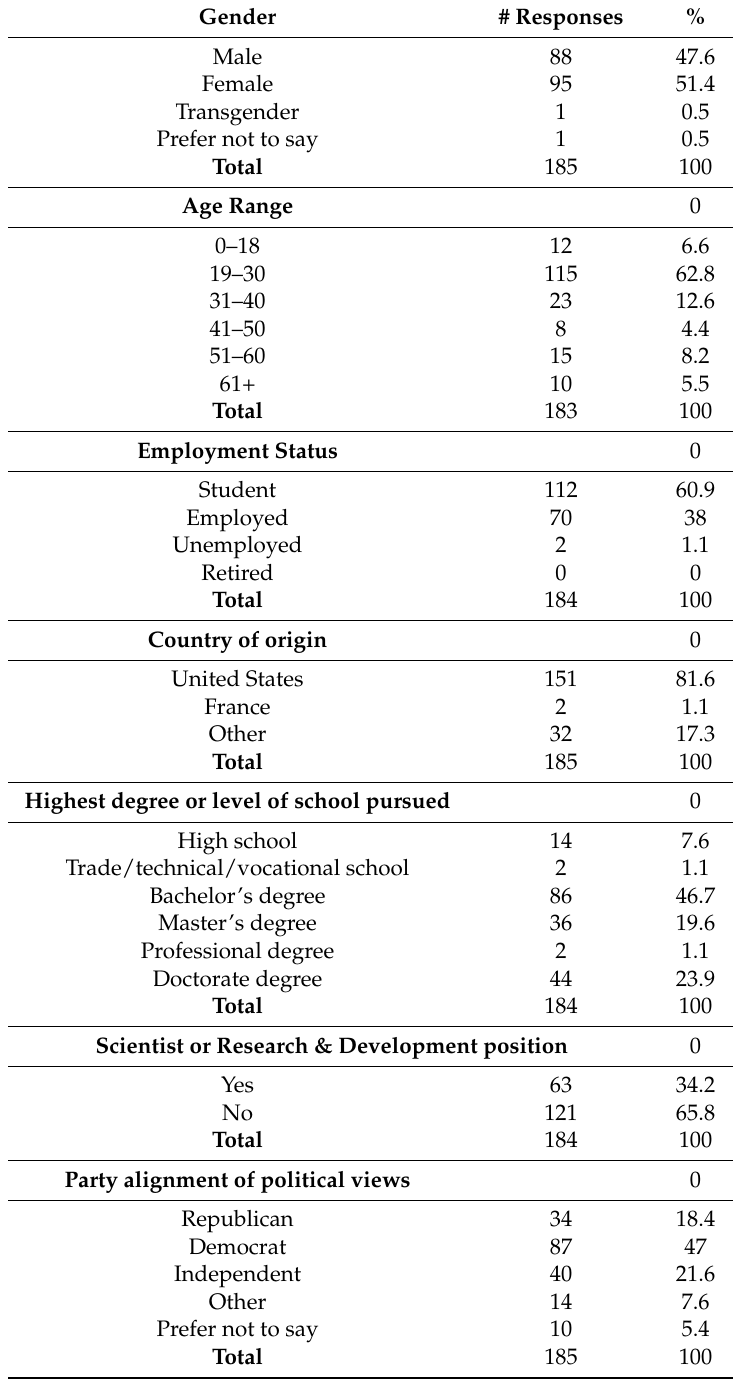
Table 1. Demographics of population